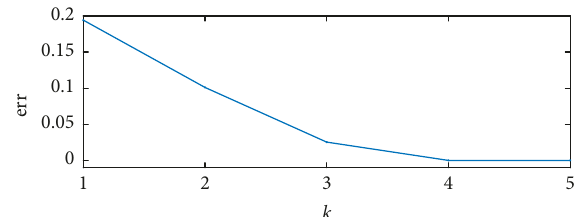
Figure 2: Error versus iteration number k for Example 3.